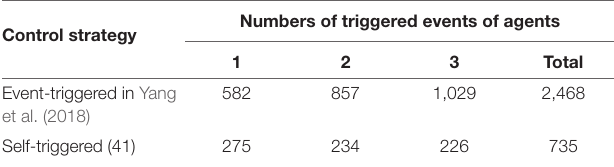
TABLE 1 | Triggered numbers of follower agents.